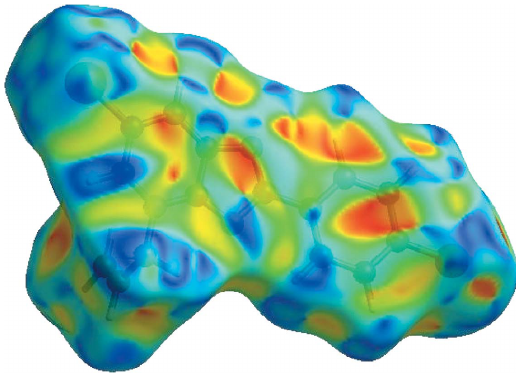
Figure 4 Hirshfeld surface of the title compound plotted over shape